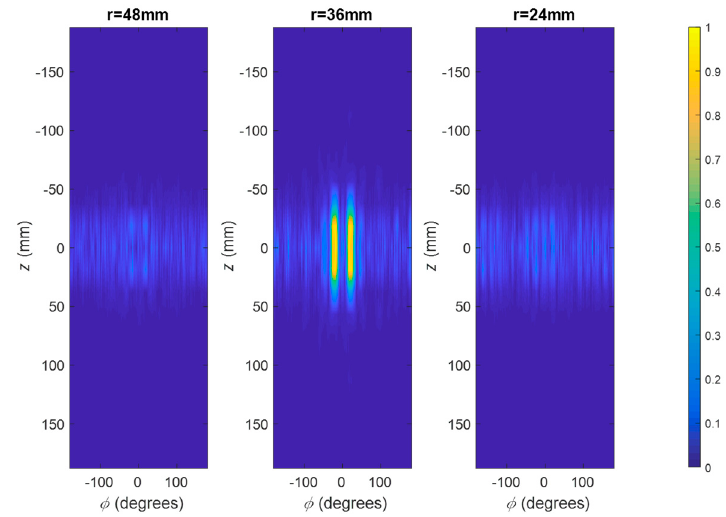
Figure 9. Normalized 3D reconstructed image of the objects shown in Figure 7 on three imaged surfaces at radii of 48, 36, and 24 mm using double frequency data collected by eight receiver antennas.